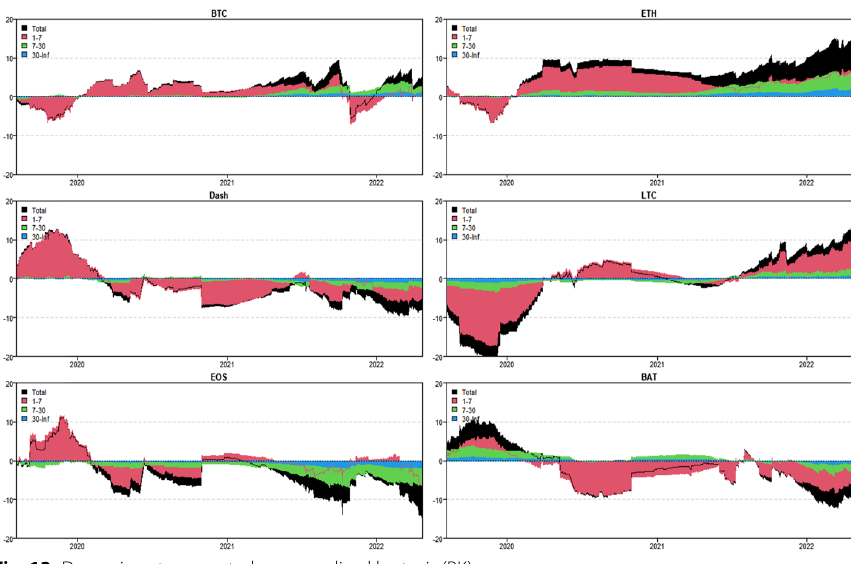
Fig. 13 Dynamic net connectedness—realized kurtosis